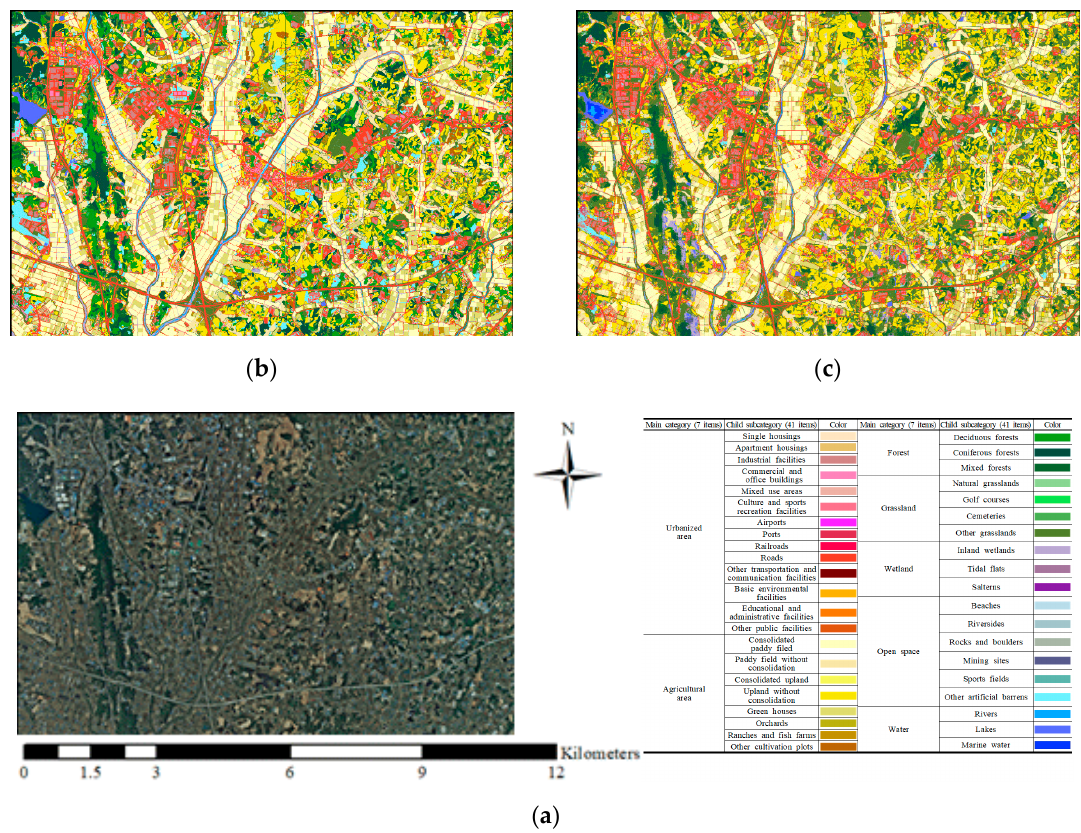
Figure 11. Photos of ( a ) Orthographic image, ( b ) land cover map, and ( c ) classification results of the Daeso-myeon